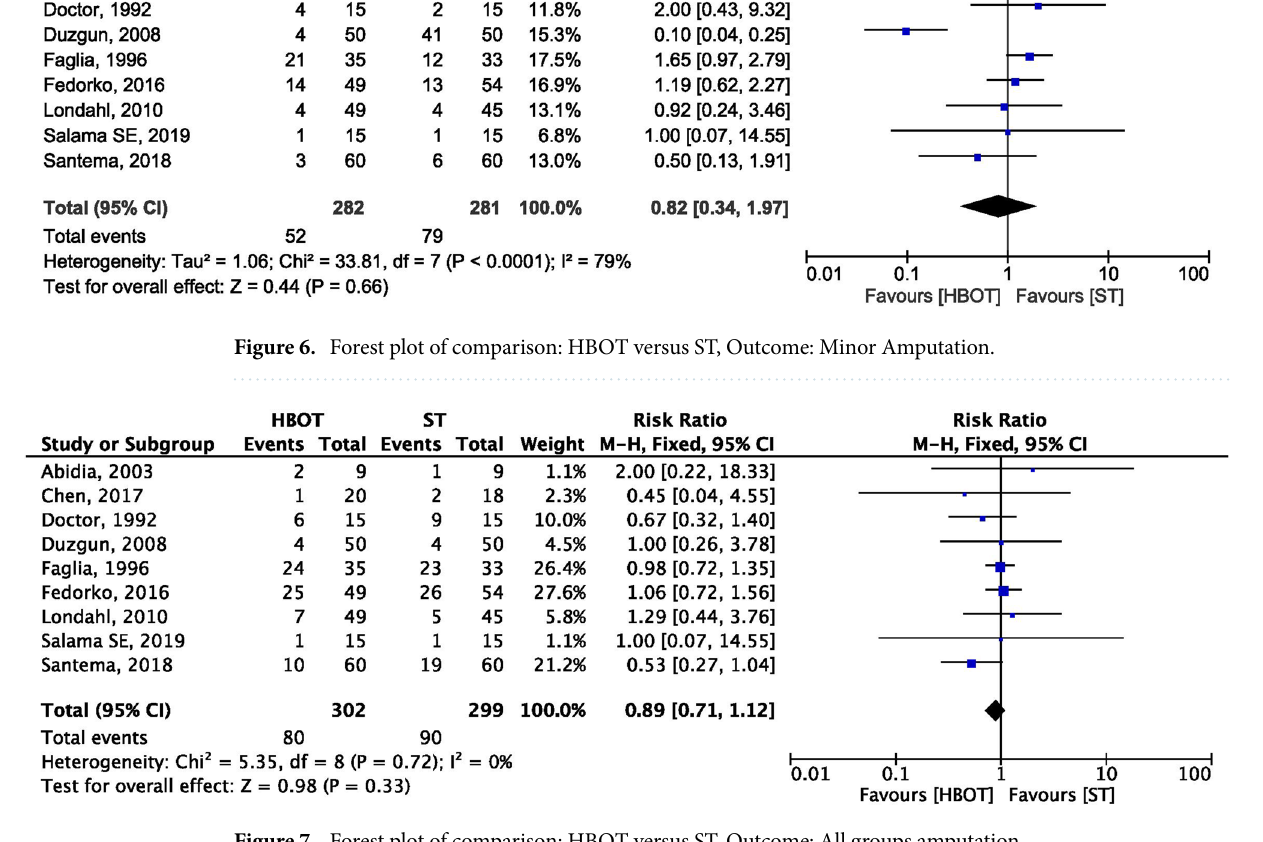
Figure 7. Forest plot of comparison: HBOT versus ST, Outcome: All groups amputation.